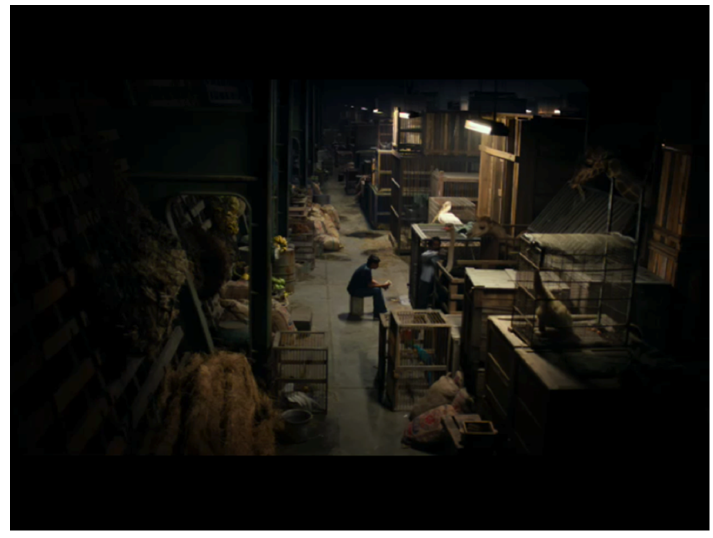
Figure 9. Pi sits in the hull of the boat, a new Noah adrift at sea.